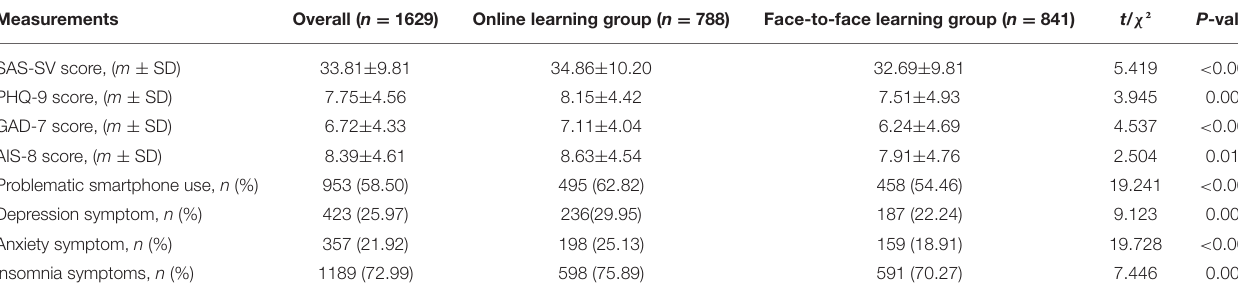
TABLE 1 | Problematic smartphone use and psychological symptoms of all 1,629 students.